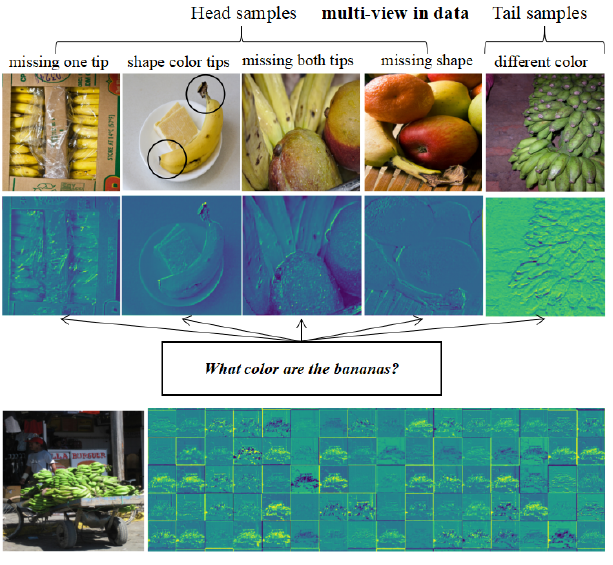
Figure 2. The VQA-CP v2 dataset contains images with multi-view (features). The authors of this paper visualize the features at the same layer in the neural network. For the same question, although the images, views and features are different, the semantic information is the same. Broadly speaking, this “multi-view” structure [12] exists both in the original data and the feature sets extracted from the middle